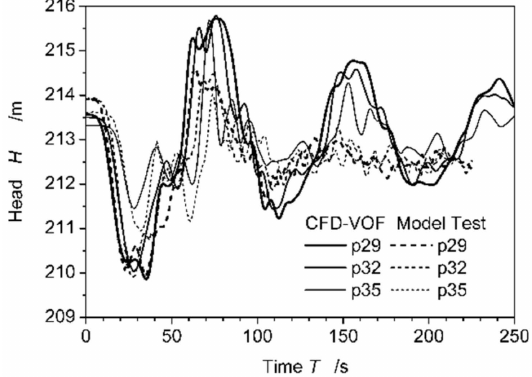
Figure 12. Comparison between the heads in di ff erent positions of the CFD–VOF results and the model test results